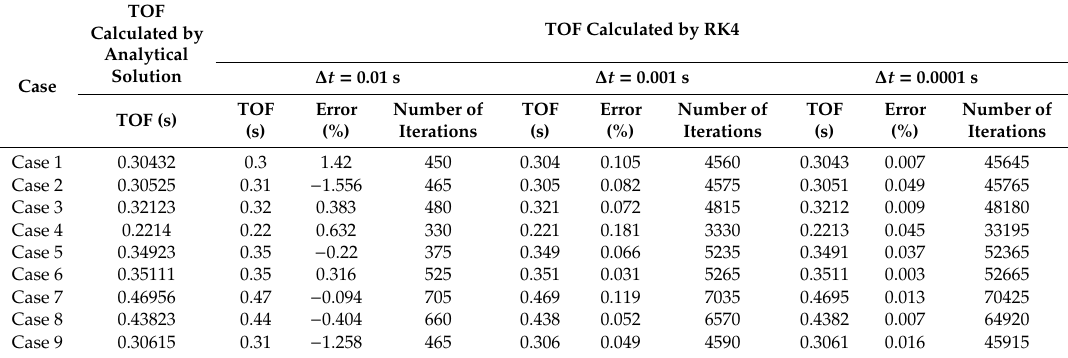
Table 1. The calculation results and error of TOF by analytical solution and RK4 method for nine